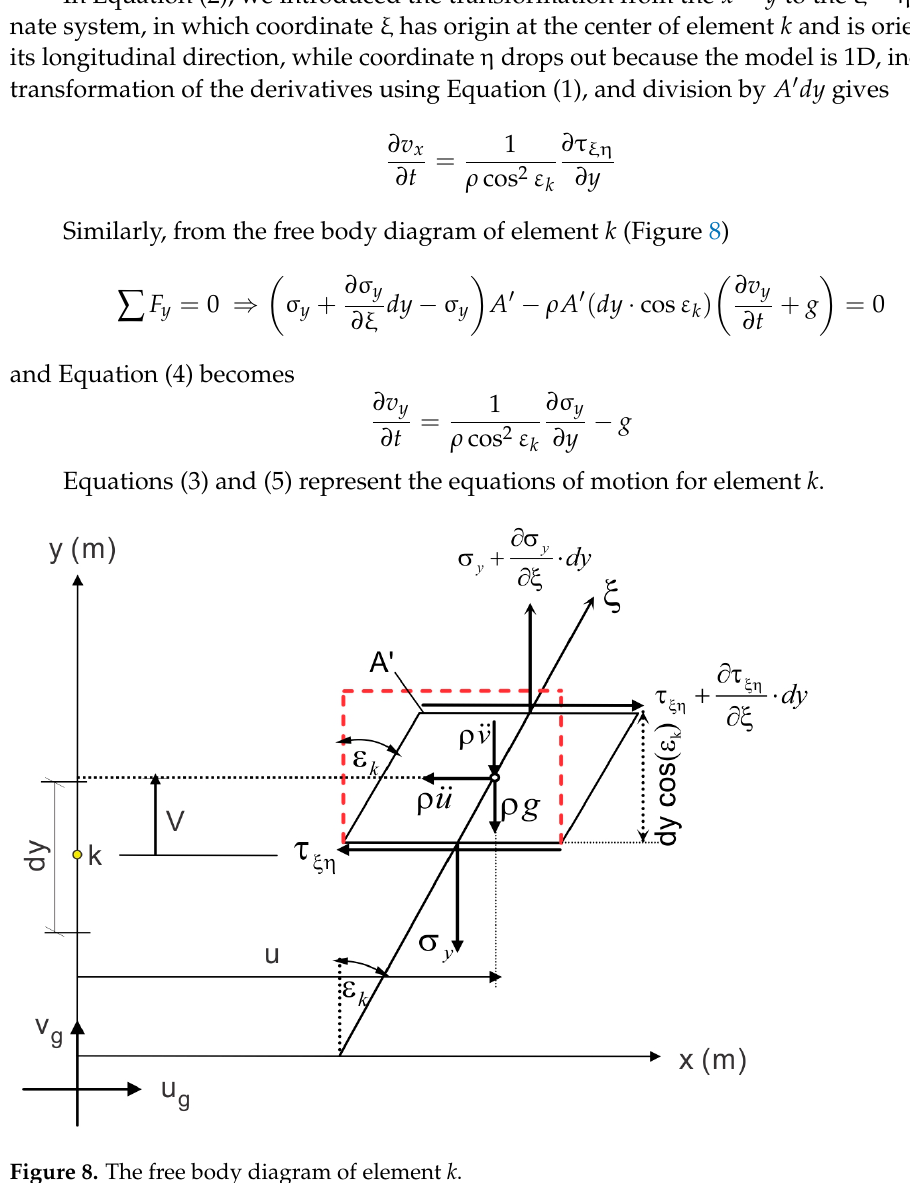
Figure 9. The connecting element between two points, k and 1 k + .